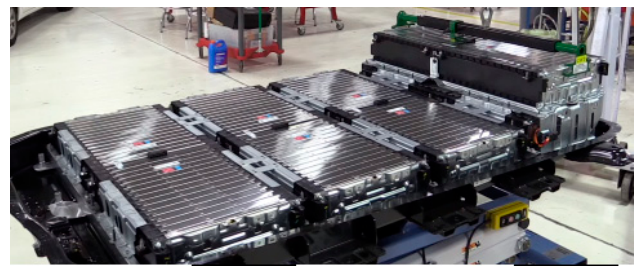
Figure 9. Chevy Bolt battery with cooling metal plates on the surface of battery cells.